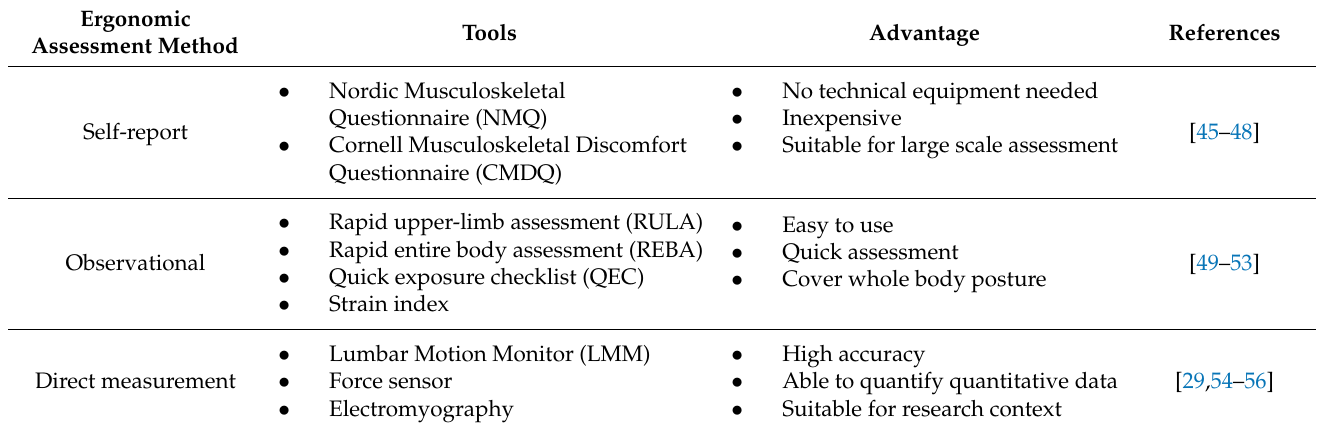
Table 2. The advantage of ergonomics risk assessment